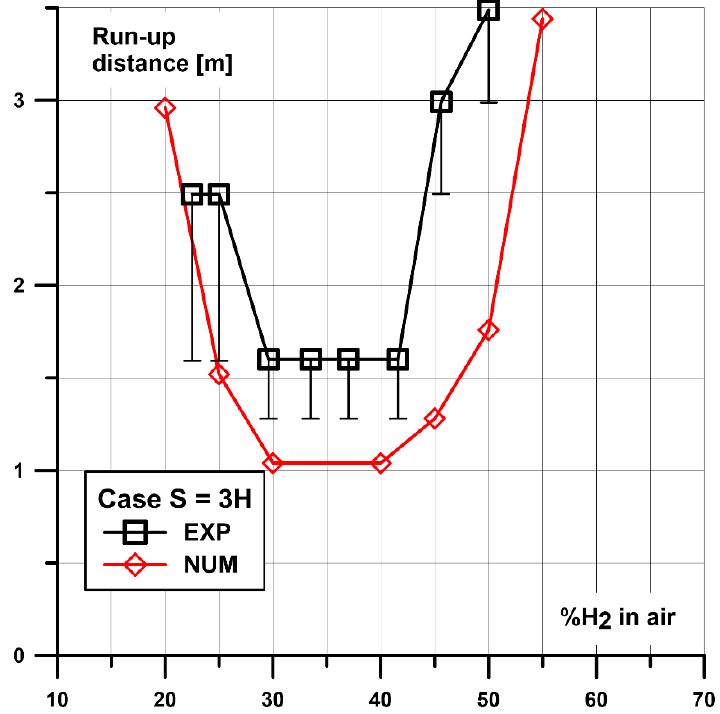
Figure 17. Run-up distances for S = 3H spacing geometry. Experimental data whiskers cover the distance range of possible transition to detonation placement.